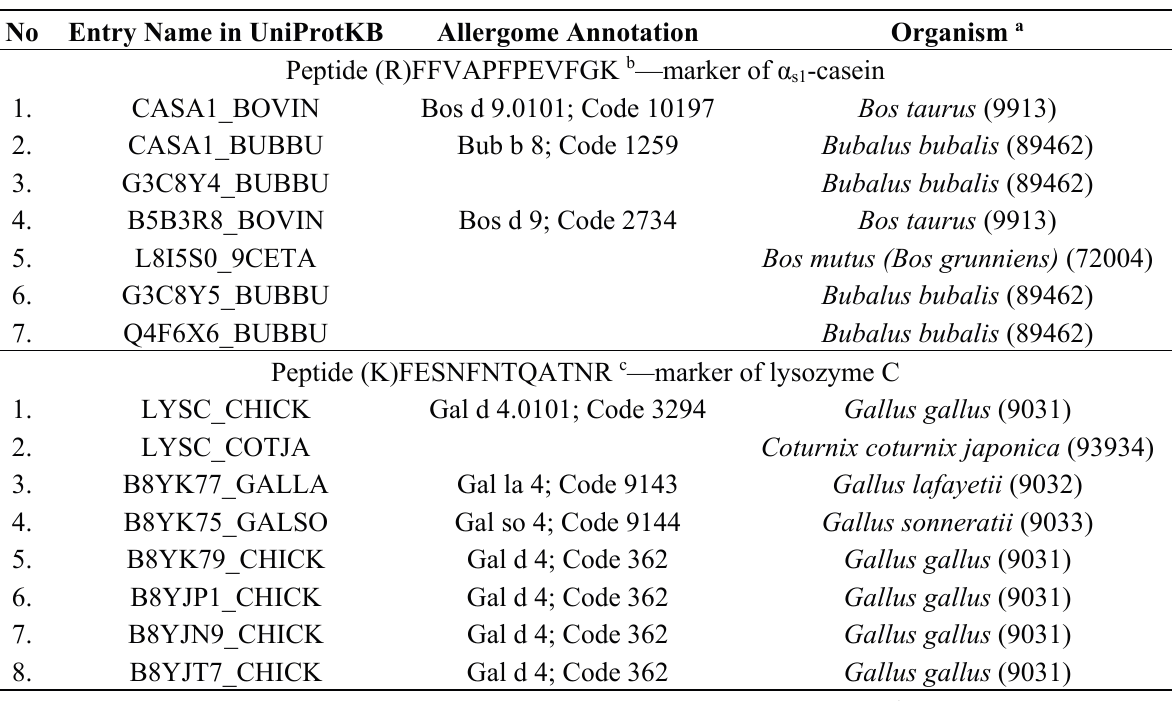
Table 4. Proteins containing fragments FFVAPFPEVFGK and FESNFNTQATNR, used as markers of α s1 -casein from milk and lysozyme from eggs, respectively [126]. The